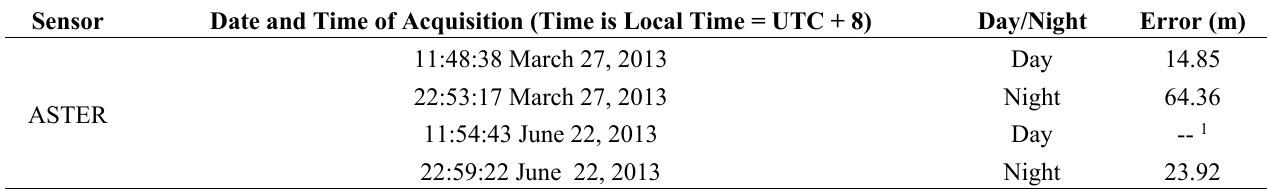
Figure 2. Ground control points (GCPs) selection during geometric correction. Green crosses are GCPs used in the registration of TIR to VNIR images (points have stable and high temperature contrast). Red crosses mark the GCPs used for registration of VNIR images to GPS data (points were selected at intersections or at street corners). Linked blue dots are GPS tracking points. Table 2. Error values for TIR to VNIR images registration.